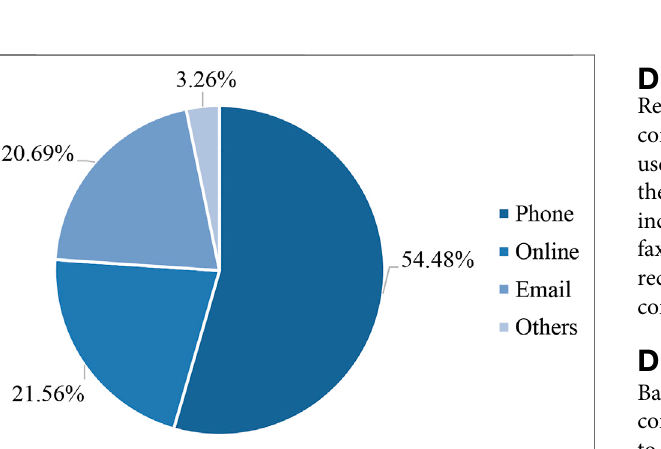
FIGURE 3 | Variation of construction-related complaints as compared to the total complaints with time.